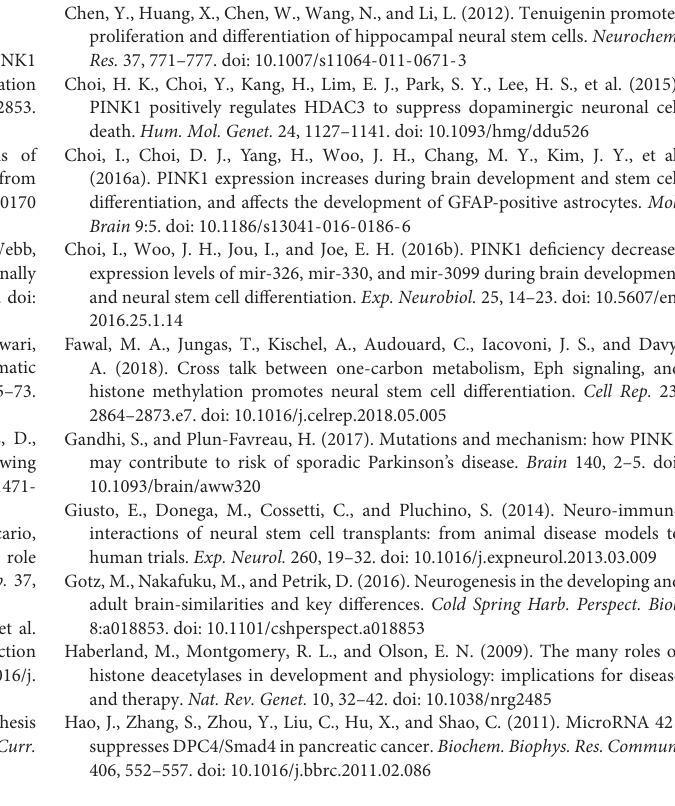
Supplementary Figure 1 | miR-421 overexpression facilitates the self-renewal of human embryonic NSCs. (A) Levels of the markers of neurons (MAP2 and TUJ-1), astrocytes (GFAP) and oligodendrocytes (CNPase) determined by immunofluorescence staining. (B) The number of neurospheres in the presence of miR-421 overexpression. (C) The diameter of neurospheres in the presence of miR-421 overexpression. (D) The number of BrdU + cells following overexpression of miR-421. (E) EdU-positive cells in the presence of overexpression of miR-421. ∗ p < 0.05 compared with D0 group. # p < 0.05 compared with mimic-NC group. Measurement data were shown as mean ± standard deviation. Unpaired t -test was adopted to analyze the data of two groups. Cell experiments were repeated in